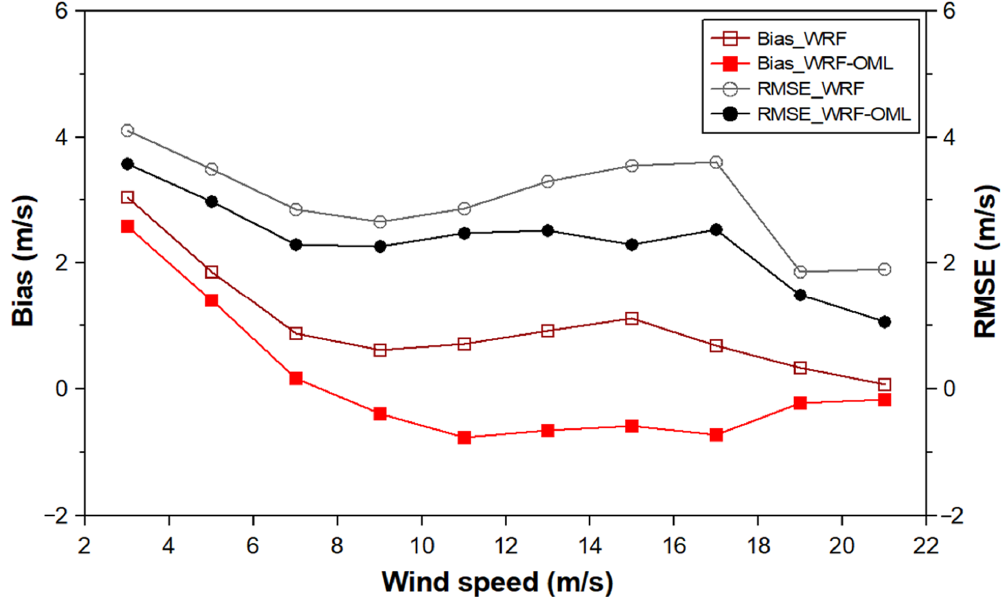
Figure 7. Bias and root mean square error (RMSE) of simulated results using WRF and WRF-OML (wind speed at 94 m height) models with wind speed.